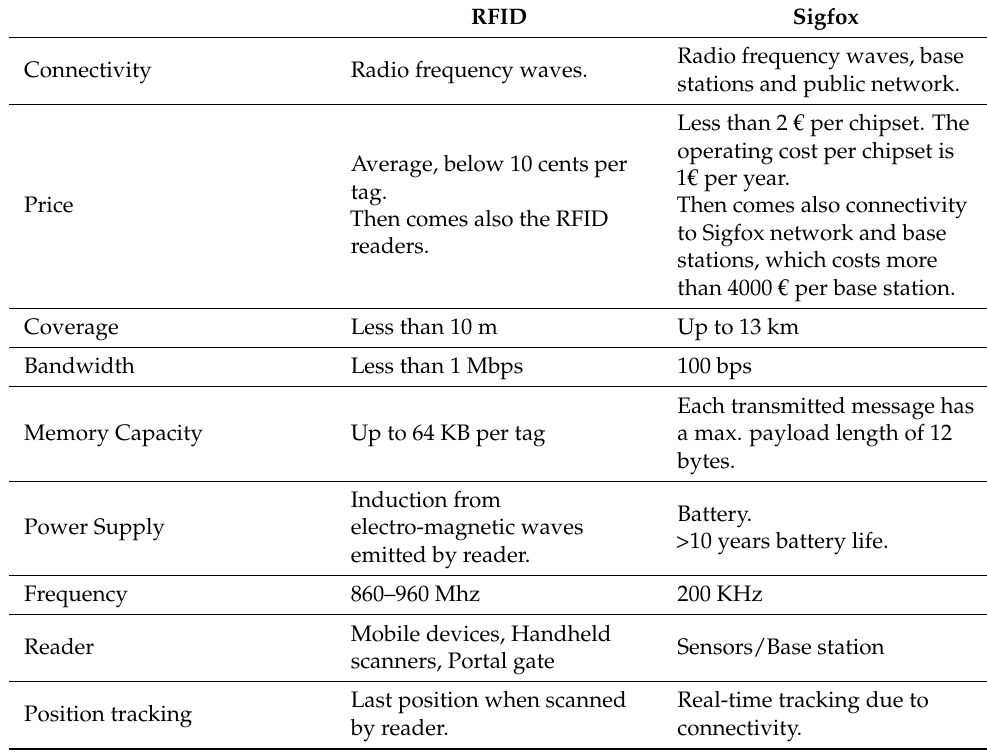
Table 3. Cons and Pros of RFID vs. Sigfox for shop floor traceability. RFID Sigfox Radio frequency